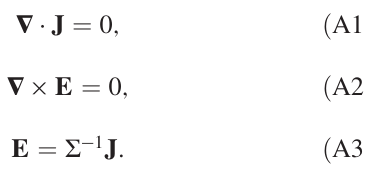
FIG. 5. Dependence of skin depth at the lowest resonance frequency, δ ½ ω c ð L Þ(cid:4) , on sample thickness L and for ρ 0 ¼ 10 μ Ω cm, for L ≳ 5 μ m, δ ≪ L